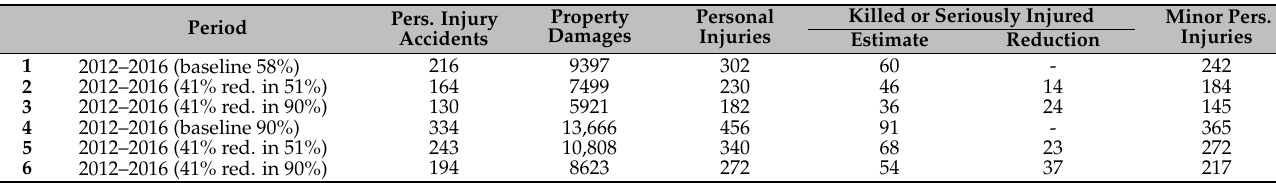
Table 8. Average numbers for accidents involving personal injuries and property damage per year during the period 2012–2016. Calculation example of a 41% reduction in accident risk as a result of “Anticipatory driver training”. Rows 1–3 include trucking companies (58% of HGV kms), while Rows 4–6 also include companies involved in transport for own account (90% of HGV